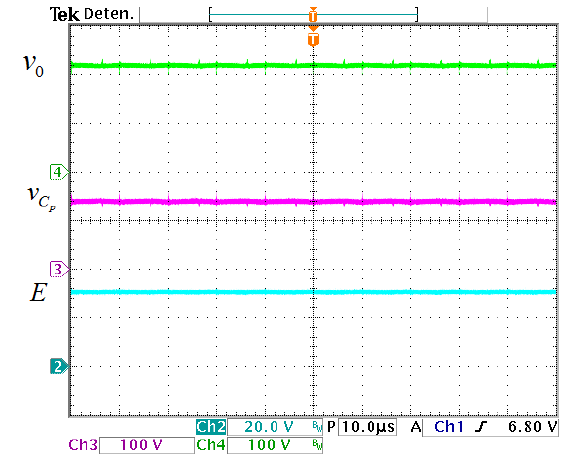
Figure 20. Voltage waveforms of the prototype. (From top to bottom) Output capacitor voltage v